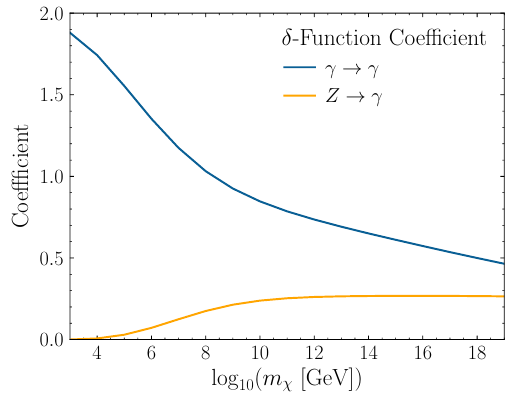
( x ; m 2 , 0) or i = γ and Z . More χ / i